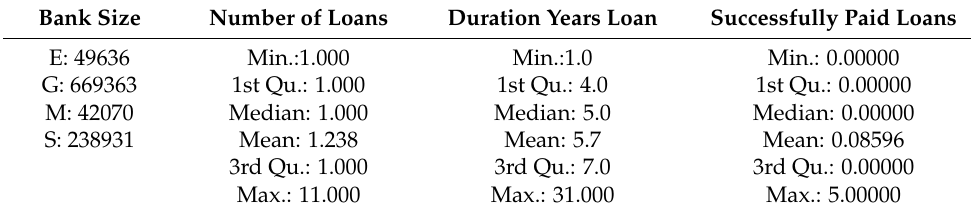
Table 3. Summary